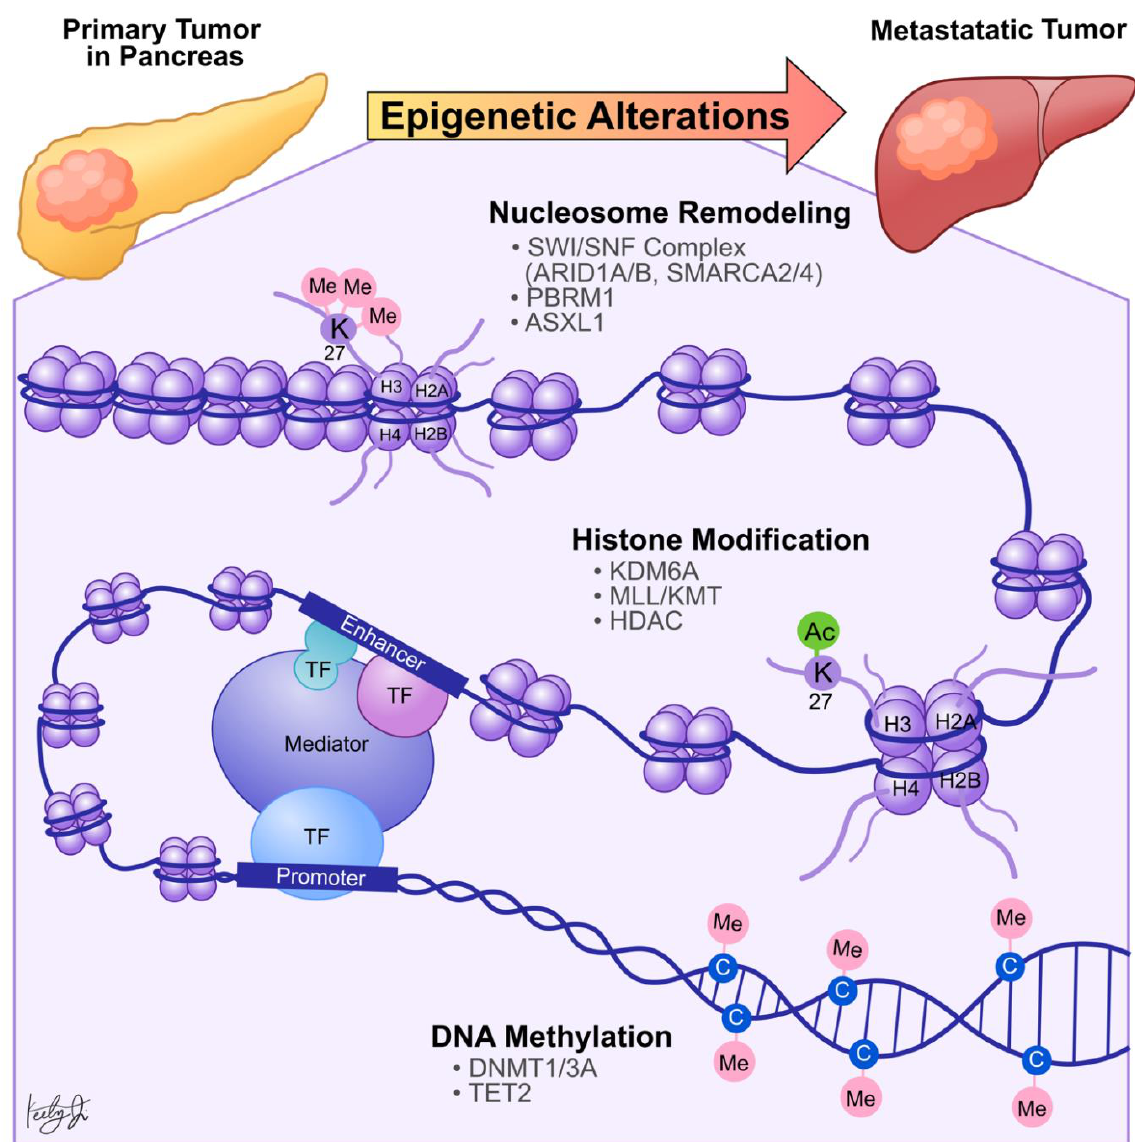
Figure 2. Summary of the epigenetic mechanisms behind PDA metastasis. Metastatic PDA tumors have aberrant epigenetic profiles that are different from PDA primary tumors. Nucleosome remodeling and histone modification (e.g., acetylation of histone 3 lysine 9) increase chromatin accessibility, allowing for transcription factor binding and gene transcription. On the other hand, DNA methylation of CpG islands leads to gene repression. These processes are mediated by epigenetic regulators, some of which are noted in the figure.